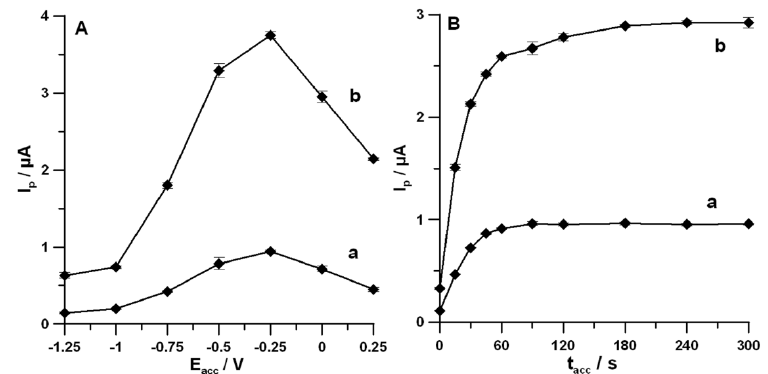
Figure 5. E ff ects of E acc ( A ) and t acc ( B ) on DF current response. (a,b) in ( A ) represent the responses for DF concentrations of 0.01 and 0.05 µ mol L − 1 , respectively. (a,b) in ( B ) represent the responses for DF concentrations of 0.01 and 0.05 µ mol L − 1 , respectively. The DPAdSV parameters in ( A ) are t acc of 30 s, A of 100 mV, t m of 40 ms, and ν of 175 mV s − 1 ; the DPAdSV parameters in ( B ) are E acc of − 0.25 V, A of 100 mV, t m of 40 ms, and ν of 175 mV s − 1 .